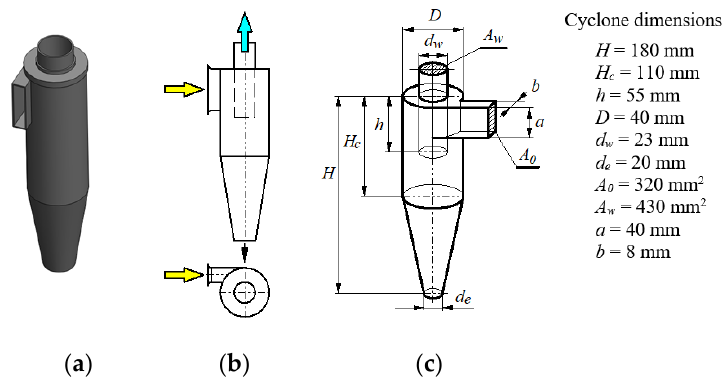
Figure 23. Return cyclone with tangential inlet D -40: ( a ) general view, ( b ) functional diagram and ( c ) characteristic dimensions.